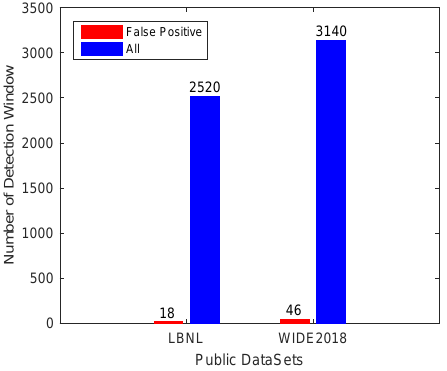
Figure 16. Detection results in public datasets.